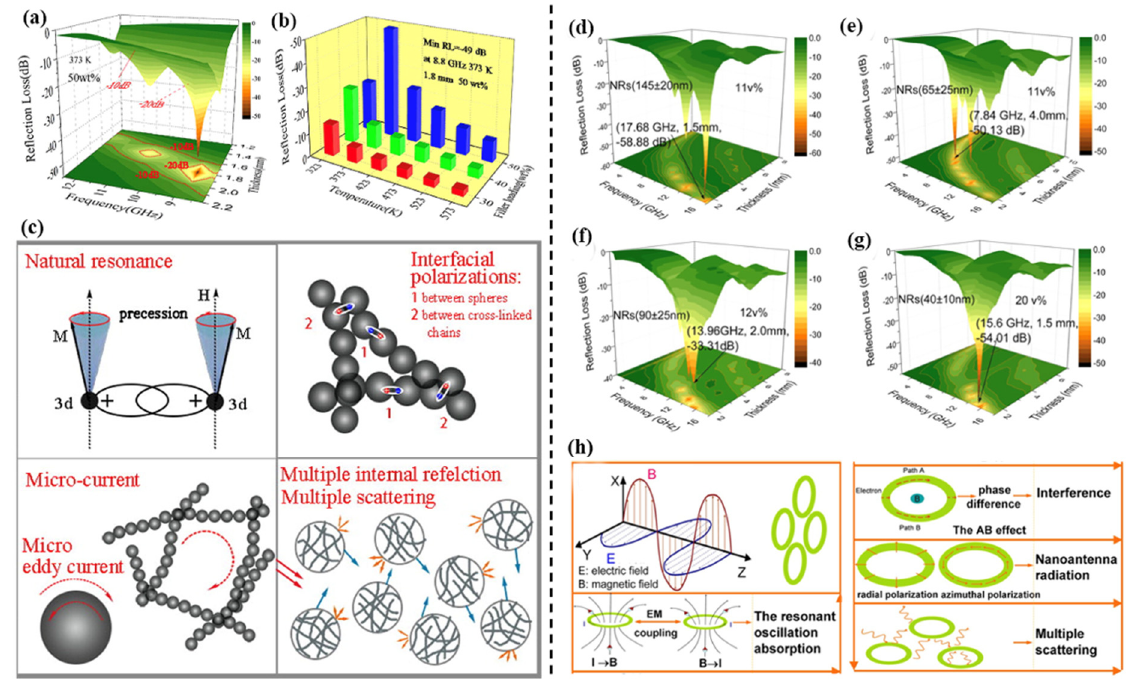
Figure 7. ( a ) 3D plot of RL versus frequency and thickness. ( b ) Maximum RL versus temperature and the filler loading. ( c ) Schematic for RL mechanism of the nickel nanochains. Reproduced with permission from Liu et al. [114], Electromagnetic property and tunable microwave absorption of 3D nets from nickel chains at elevated temperature; published by American Chemical Society, 2016. ( d – g ) RL versus volume fractions and thickness. ( h ) Contribution of the ring-like configuration to microwave absorption. Reproduced with permission from Tong et al. [13], Tunable dielectric properties and excellent microwave absorbing properties of elliptical Fe 3 O 4 nanorings; published by American Institute of Physics, 2016.